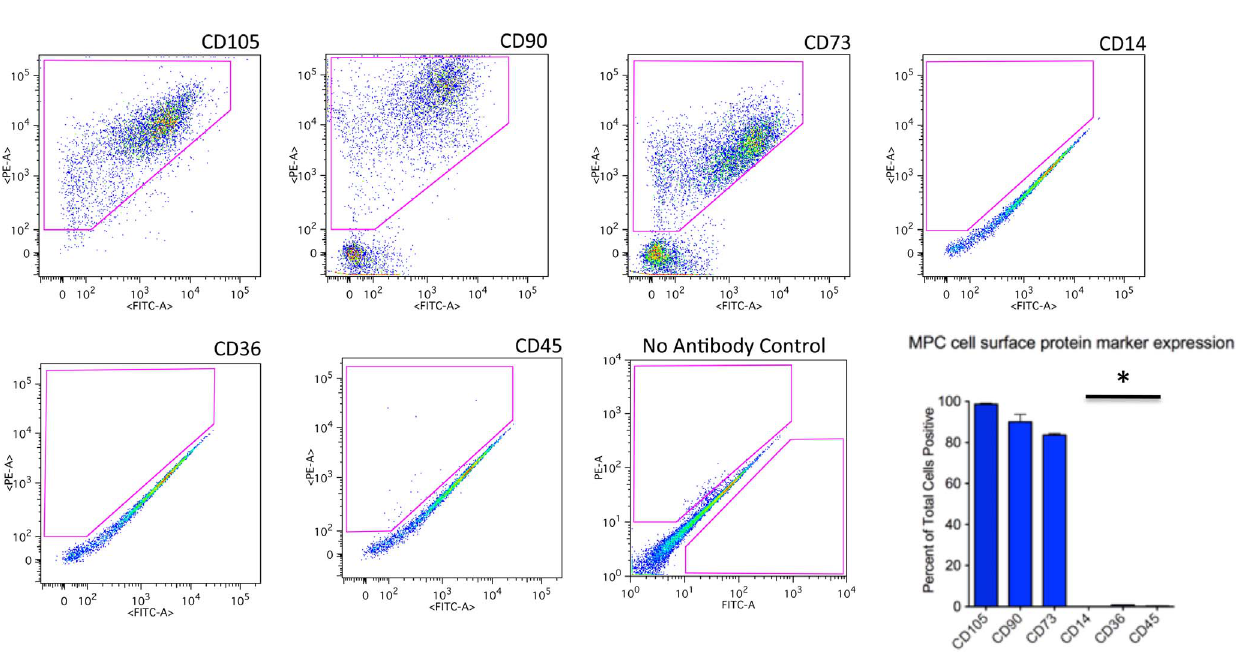
Fig. 2. Flow cytometry analysis of cells isolated from traumatized muscle by 2-hour adherence to TCPS. Cells were isolated and cultured after 2-hr adherence to TCPS (Figure 1B). The cells were then processed for flow cytometry using fluorescent-conjugated antibodies against the cell surface markers indicated in the figure. The gated regions, indicated by a red geometric figure within the plot, containositive cells. Also shown is a bar graph reflecting the number of positive cells for each marker (mean ¡ SEM, n 5 8). Significant difference is noted (*) between the CD14, CD36, CD45 as compared to CD105, CD90, CD73 (Mann Whitney U Test, p #